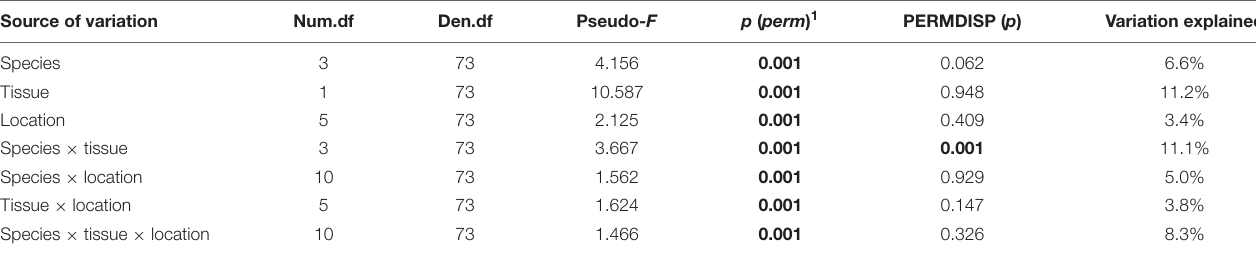
TABLE 1 | PERMANOVA main test for the structure of the bacterial community associated with the native seagrasses Halodule wrightii and Thalassia testudinum and the invasive Halophila stipulacea across leaves and roots tissues in six bays of the Caribbean island of Curaçao. Source of variation